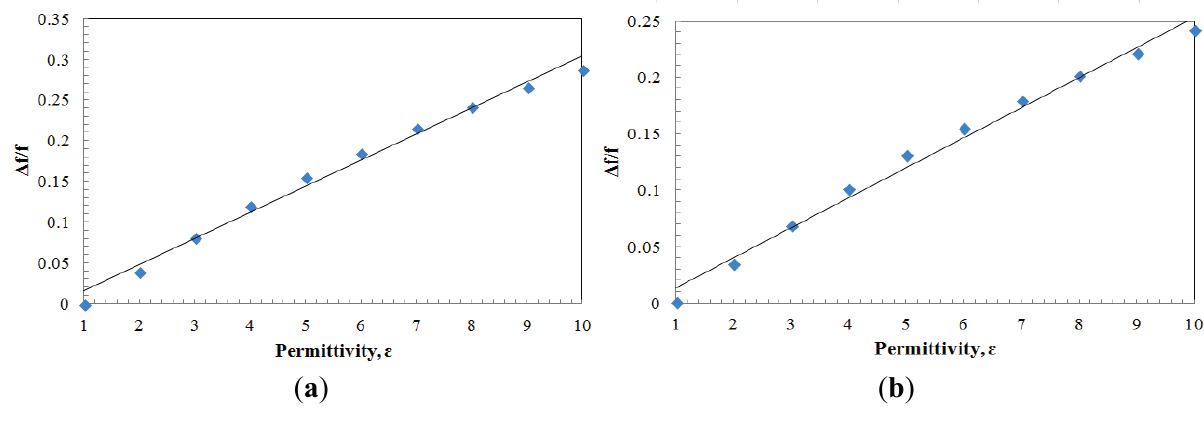
Figure 9. Relative shift ( Δ f/f ( b ) centered-gap